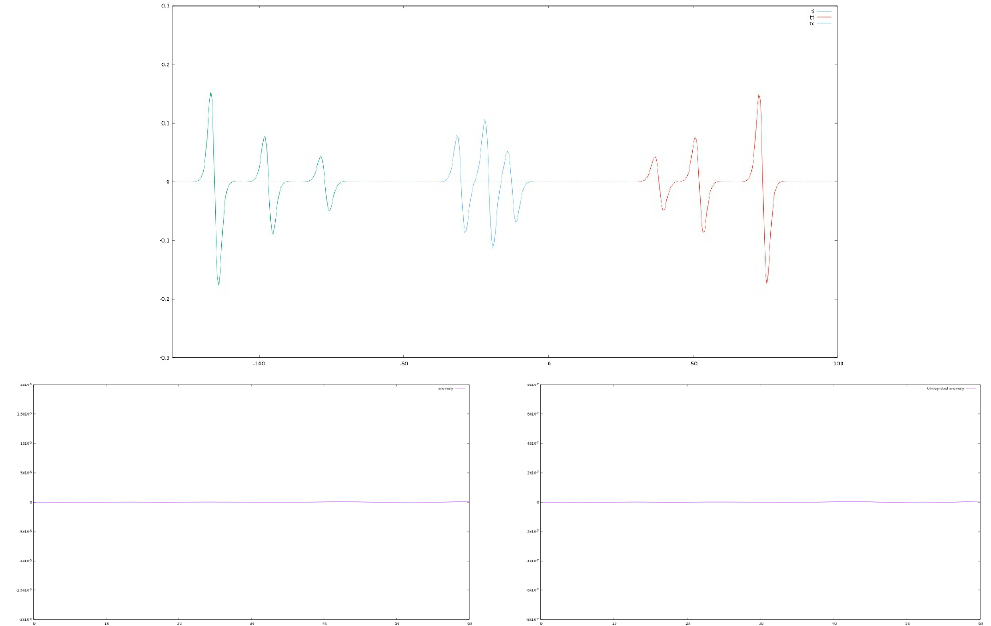
JHEP03(2020)136 Figure 8 . Top (cid:12)gure shows the anomaly density of e (cid:12) (3) (4.5); i.e. the function ( (cid:0) 6 uu x v t ) plotted in x -coordinate for three successive times, t i = before collision (green), t c = collision (blue) and t f = after collision (red), for the 3-soliton collision of (cid:12)gure 3. Bottom (cid:12)gures show the plots of the anomaly e (cid:12) (3) ( t ) vs. t and the t -integrated anomaly R t e (cid:12) (3) vs. t , t i